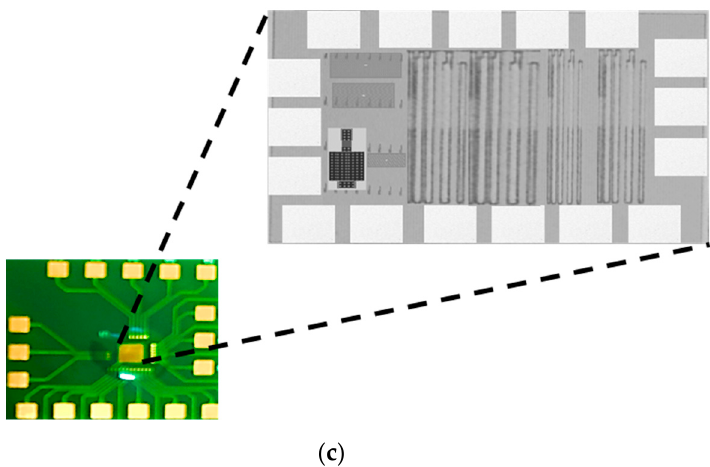
Figure 8. CMOS retina neuron IC with its ( a ) schematic, ( b ) layout, and ( c ) microchip photograph.